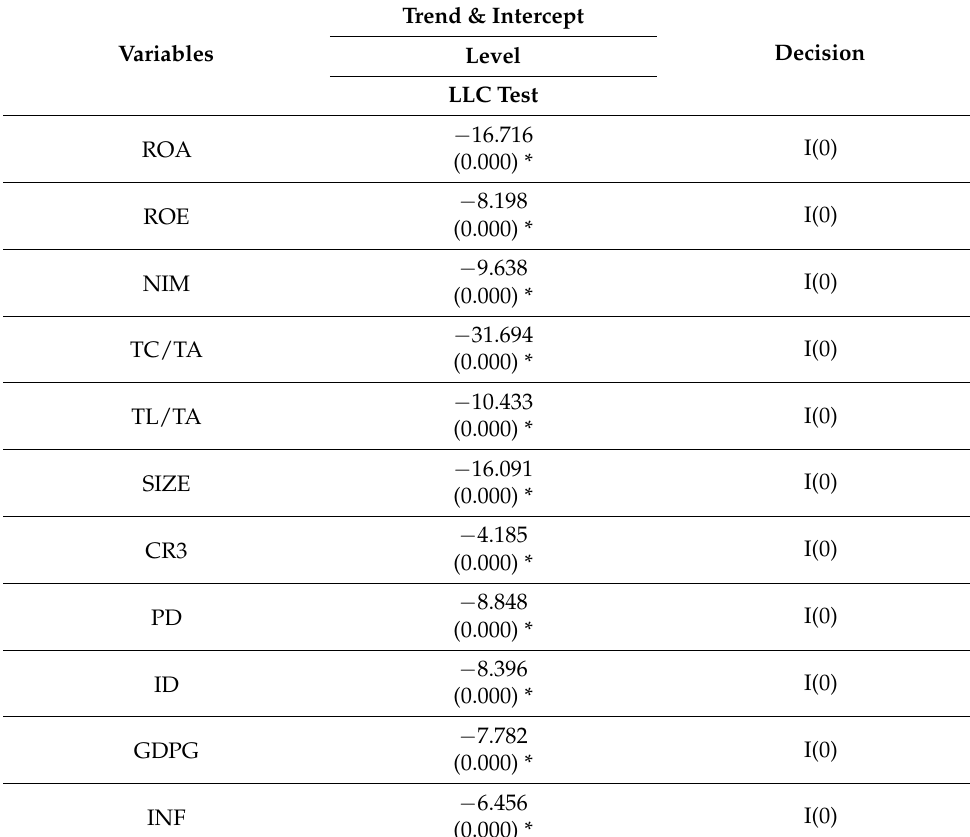
Table 2. Unit root test for